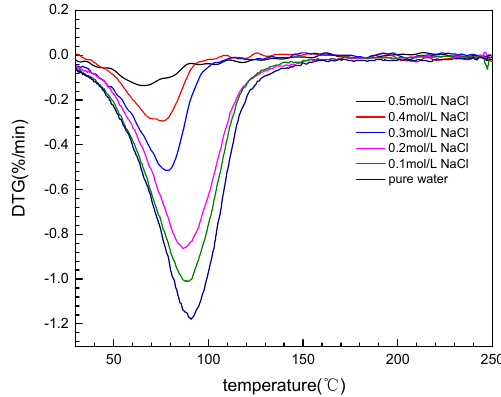
Figure 3. DTG curves of dispersed montmorillonite samples.